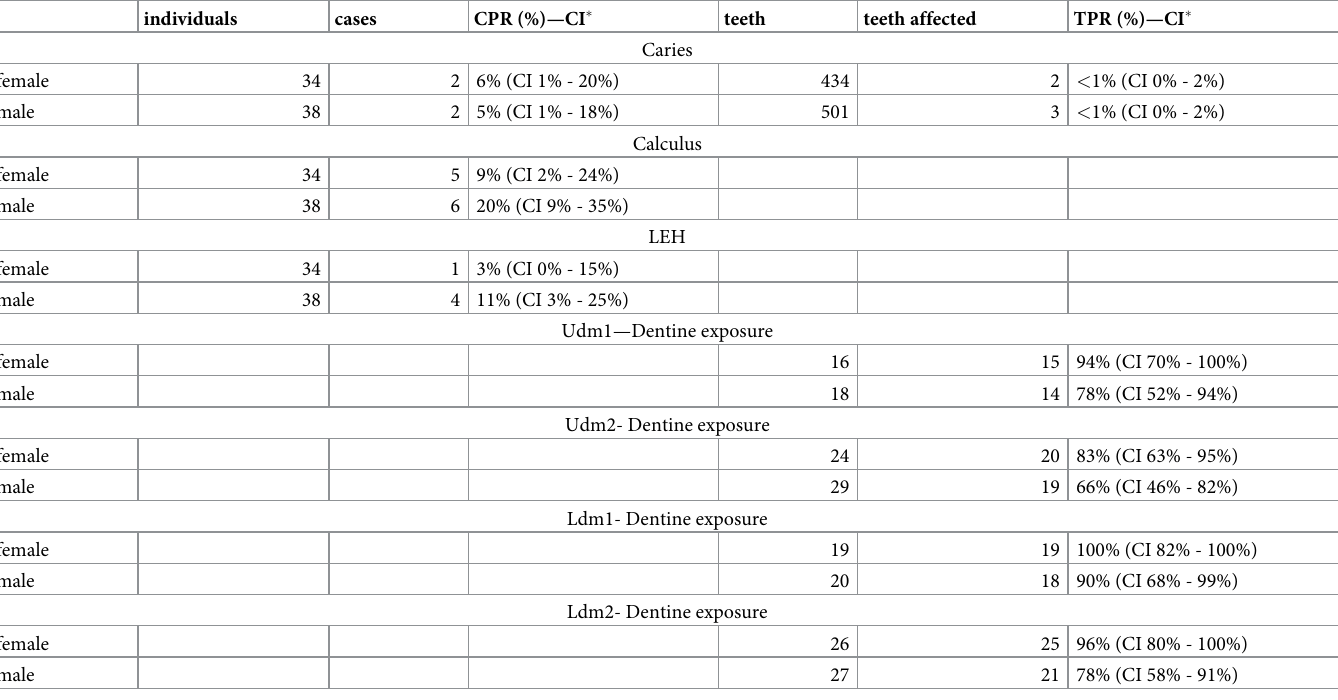
Table 5. Comparison of crude prevalence rate (CPR) and true prevalence rate (TPR) of caries, calculus and deciduous molar dentine exposure between male and female children.